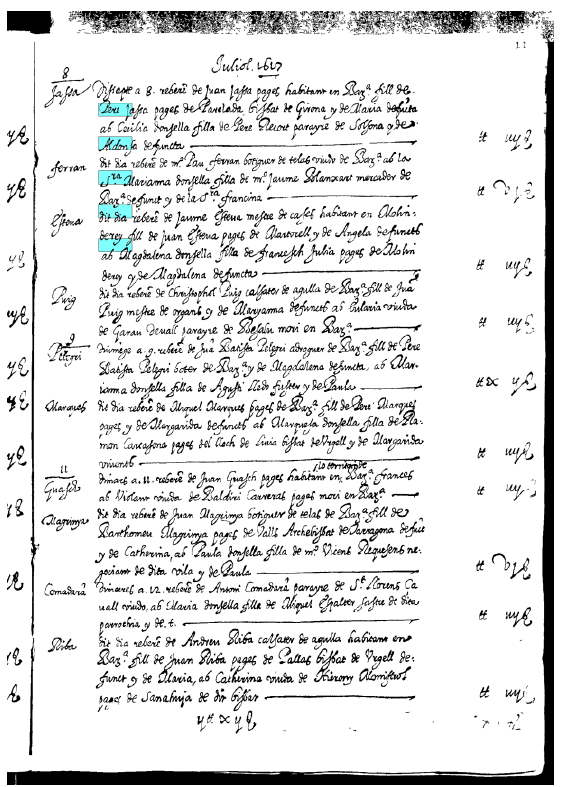
Figure 5. Possible localization of appropriate fragments on the page. The required number of fragments is M =